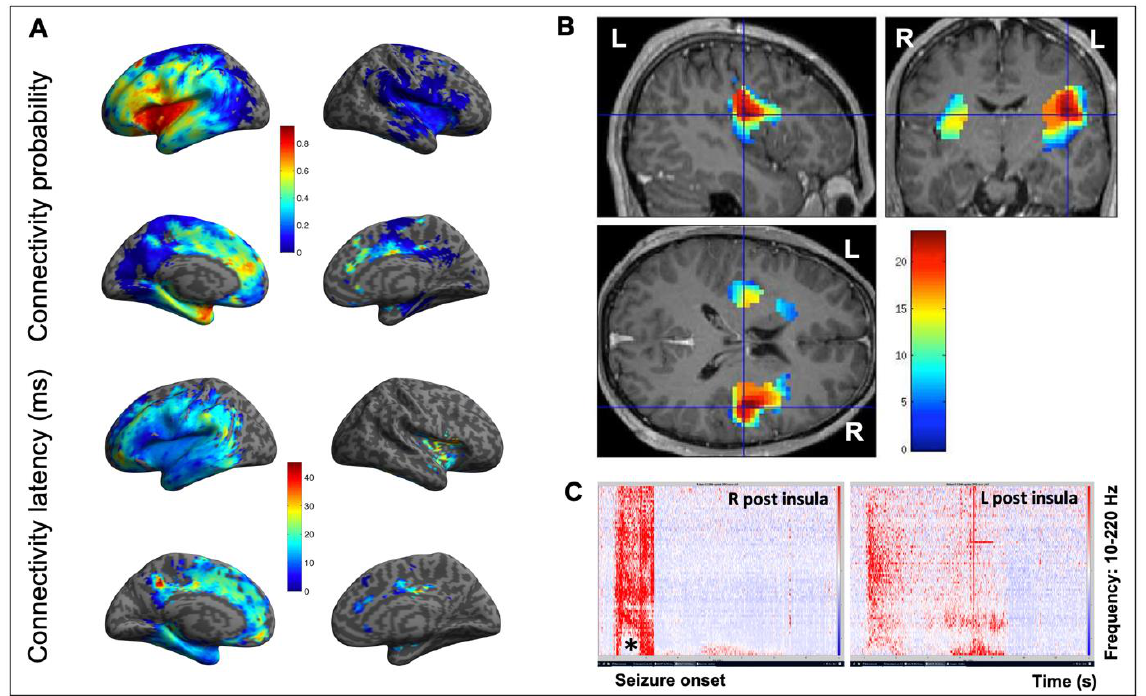
Figure 3. Connectivity of the insula. ( A ) Connectivity probability (upper part) and connectivity latency (lower part) maps obtained using CCEPs of the insula in 107 patients of the F-tract database (f-tract.eu) (unpublished data). The insula is part of a dense and widely extended network in which CCEPs propagate quickly, first with a higher probability around the insular DCS site and then to other cortical regions. ( B ) Epileptogenicity map of an SEEG-recorded spontaneous seizure, which evaluates the propensity of a brain region to generate significant fast activities (60–200 Hz) at seizure onset. This 21-year-old male patient was suffering from seizures characterized by a painful reflex left arm sensation followed by loss of contact, bilateral dystonic posturing of the upper limbs, hypermotor behavior, and postictal aphasia. Note how both insula are involved at seizure onset, though with a right-side predominance, which underlines how lateralization can be an issue in insular epilepsy due to the close and fast inter-insular connections. ( C ) Time frequency analysis at seizure onset of the same seizure, which confirms the simultaneous and asymmetric involvement of two homologous insular subregions (L and R postero-superior insula). Note how fast frequencies are suppressed (*) concurrently with the increase in high frequencies. L: left; R: